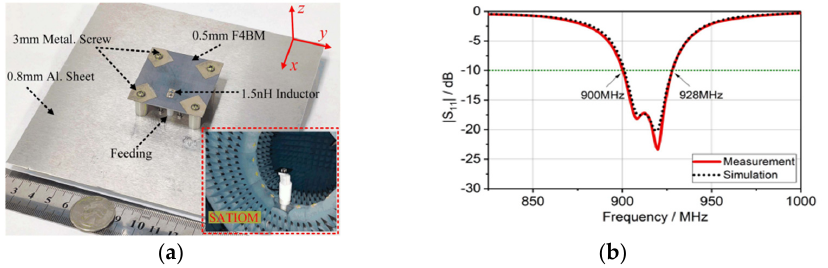
Figure 22. CP antenna with C-DRRs: ( a ) fabricated prototype; ( b ) reflection coefficient [92].